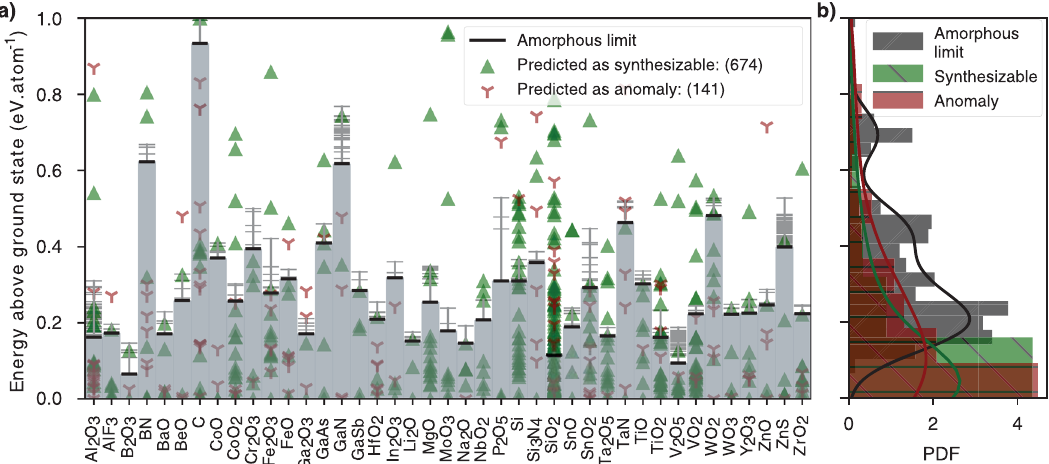
Fig. 8 Comparison of synthesizability predictions of the CAE + MLP classi fi er (this study) with the predictions from the Stability Skyline model of ref. 7 . a The energy above the ground state for a total number of 815 crystalline materials studied in ref. 7 , alongside the synthesizability predictions of the CAE + MLP classi fi er. The horizontal bars indicate the amorphous energy limit calculated in ref. 7 , above which the stability skyline model predicts a crystal as an anomaly with some exceptions (more details can be found in ref. 7 ). The lowest computed amorphous energy is represented by the bold black line, while higher amorphous energies are indicated by thin gray lines. The number in front of each legend label indicates the abundance of samples in each class. All the energy values are extracted from the Materials Project database 27 . b The probability distribution function for the energy above the ground state for the predicted synthesizable crystals and anomalies (based on our model), as well as the amorphous limit obtained from ref. 7